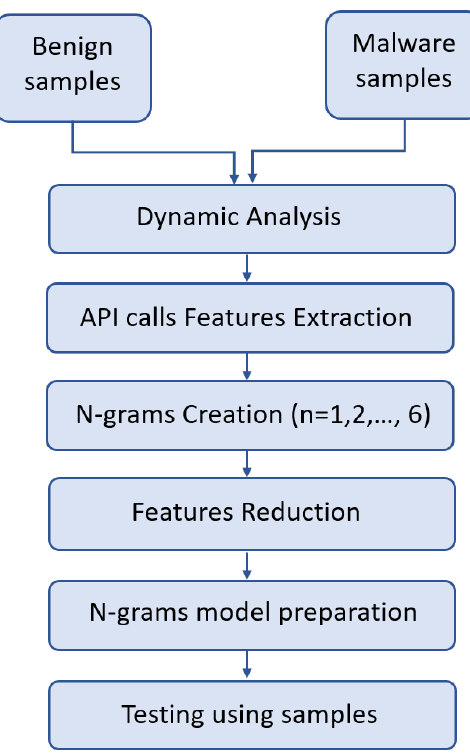
Figure 1. Architecture of proposed